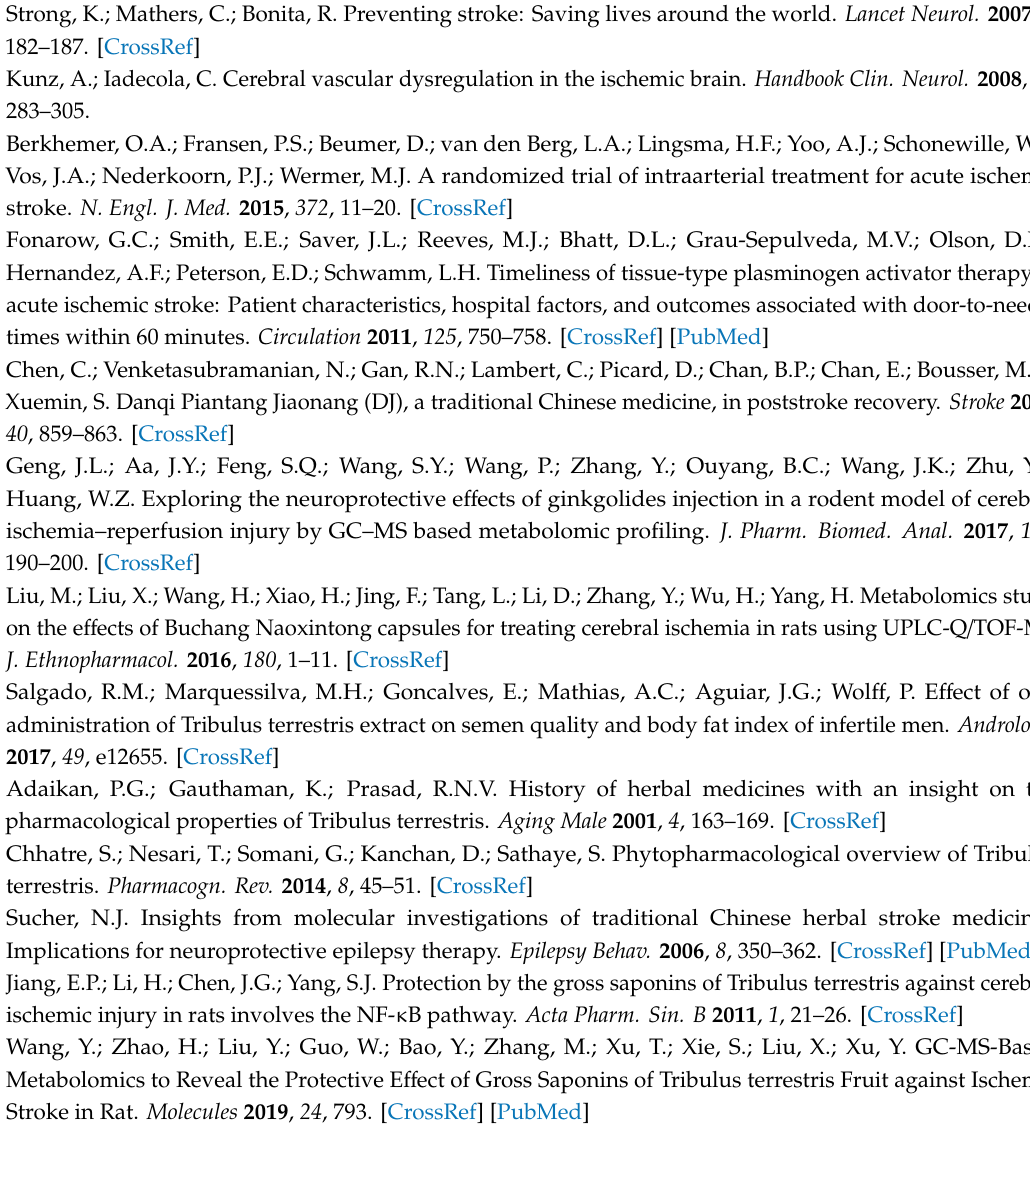
Figure S1: Representative base, peak chromatograms of urine samples from di ff erent samples acquired in both positive (A–C) and negative ion modes (D–E); Figure S2: PLS-DA permutation test of the sham and model groups based on the data obtained in positive ion mode (A) and negative ion mode (B); PLS-DA permutation test of the sham, model, and GSTTF-treated groups based on the data obtained in the positive ion mode (C) and negative ion mode (D); Figure S3: Mass spectra of the hippuric acid ion at RT 3.99_ m / z 178.0502: (A) full-scan mass spectrum, (B) tandem mass spectrum; Figure S4 The compound–target network (A) and disease–target network (B); Table S1, Information on the targets highlighted in this